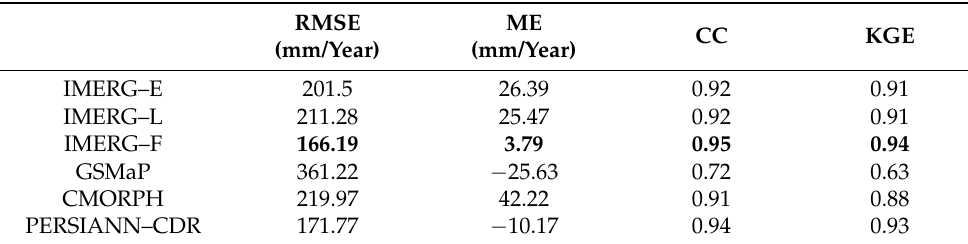
Figure 7. Scatter density plots of annual precipitation for ground interpolation product (CN05.1) versus six satellite estimates: ( a ) IMERG–E, ( b ) IMERG–L, ( c ) IMERG–F, ( d ) GSMaP, ( e ) CMORPH, and ( f ) PERSIANN–CDR. Table 6. Annual precipitation statistics of the six satellite precipitation products over mainland China from 2001 to 2015 *.